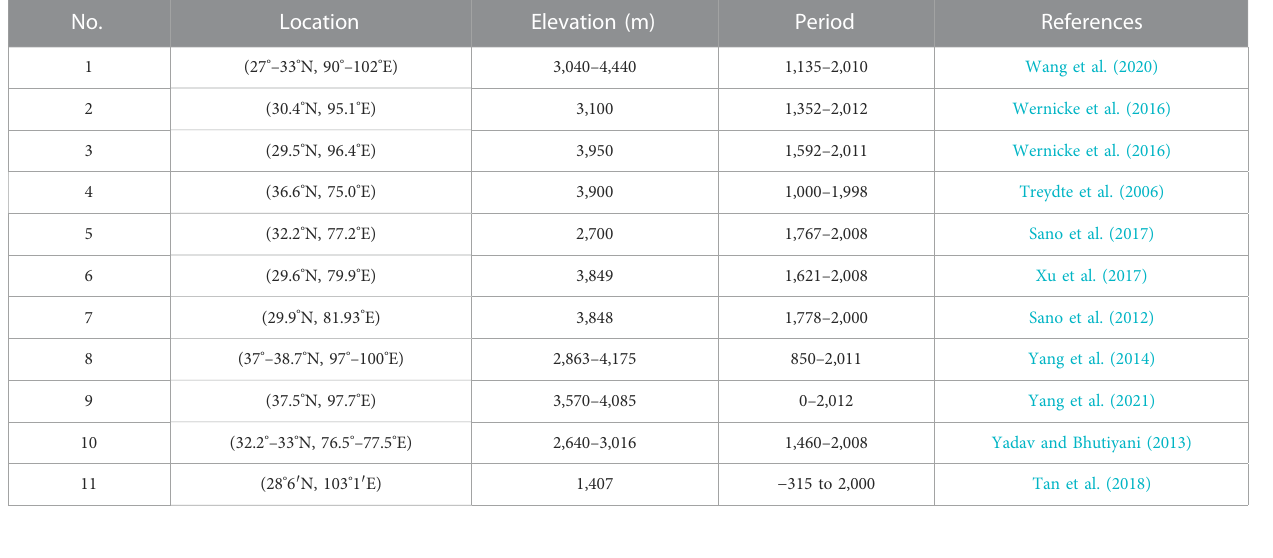
TABLE 1 Reconstructions from different regions of the TP.